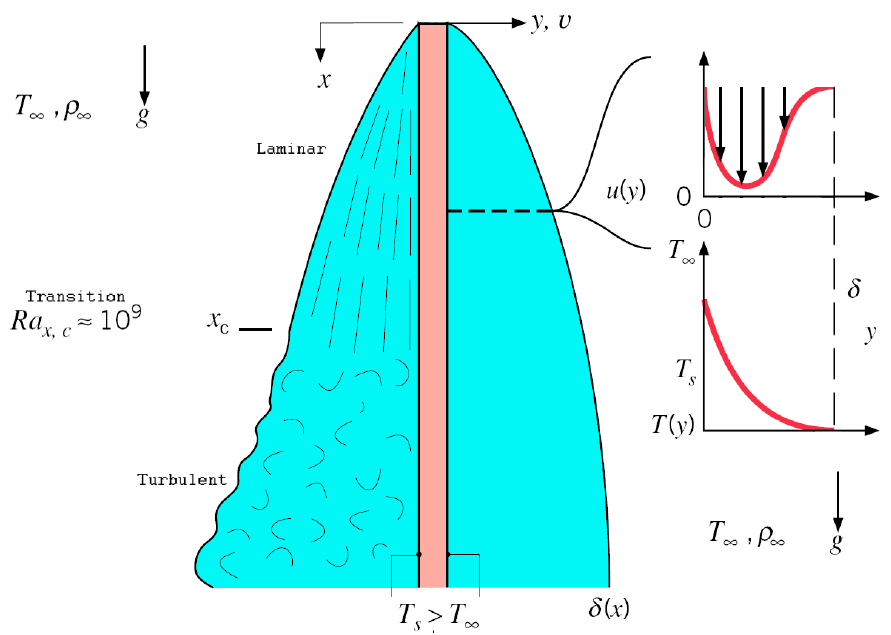
Figure 1. Left side is boundary layer laminar and turbulent-free convection on vertical plate (rib). On right is a velocity and temperature profile in the boundary layer of the vertical plate (rib).